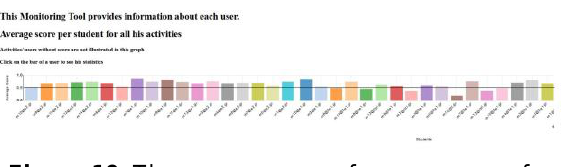
Figure 19. The average score for every user of our evaluation